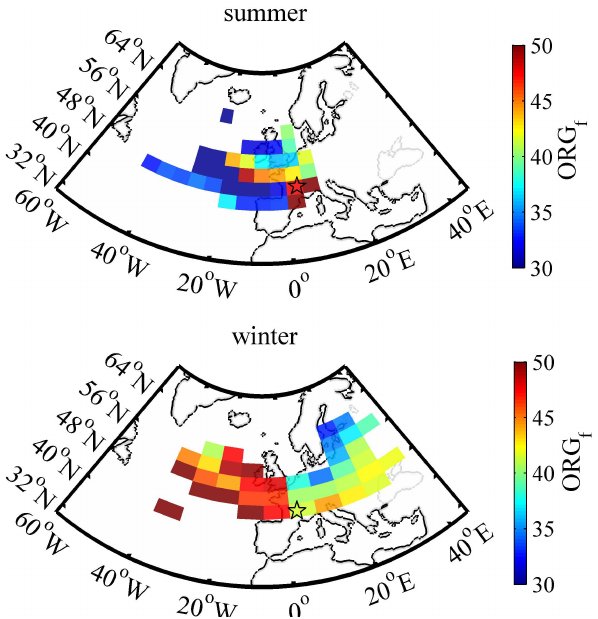
Fig. 10. Aerosol homogeneity (internal/external mixture) parameter c ∗ value with the air mass origin during summer (up) and winter (down). The star marks the location of the measurement site. For details of the calculations, see Sect. 3.3: aerosol CCN properties by air